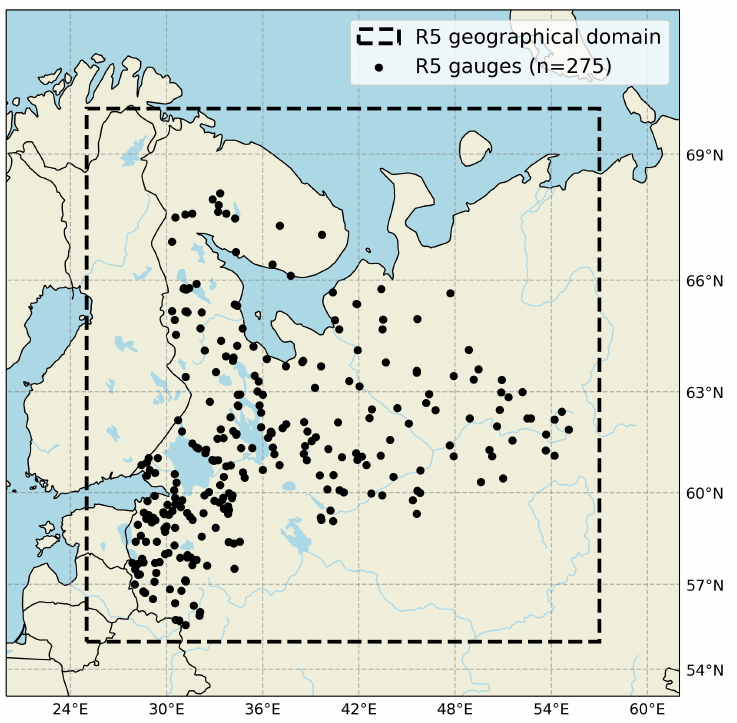
Figure 1. Gauge stations from the compiled dataset of streamflow observations of the R5